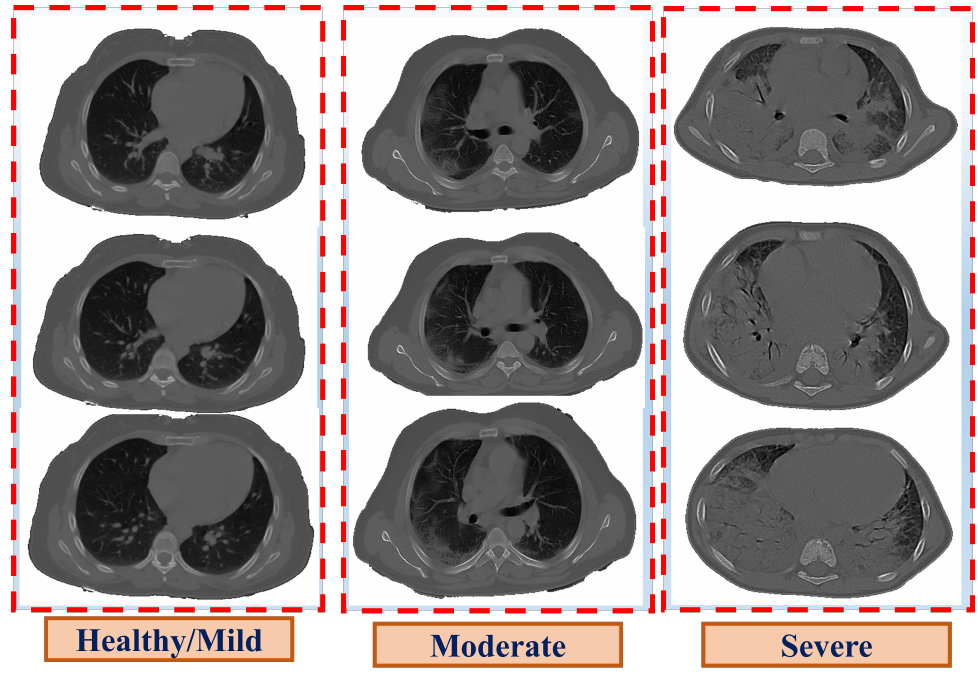
Figure 1. Illustrative examples of the three grades of